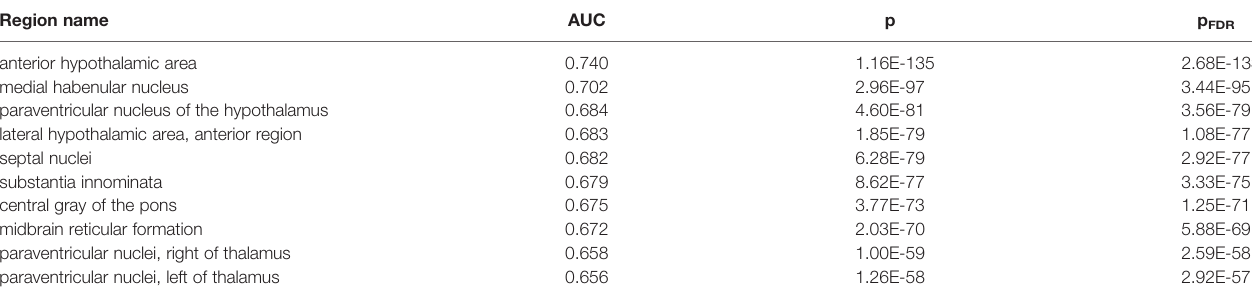
TABLE 3 | Top ten regions enriched for higher expression of genes up-regulated in samples with detected P. gingivalis